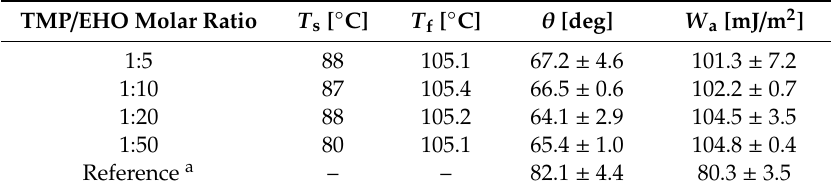
Table 3. Selected thermal and surface properties of the studied POXs.